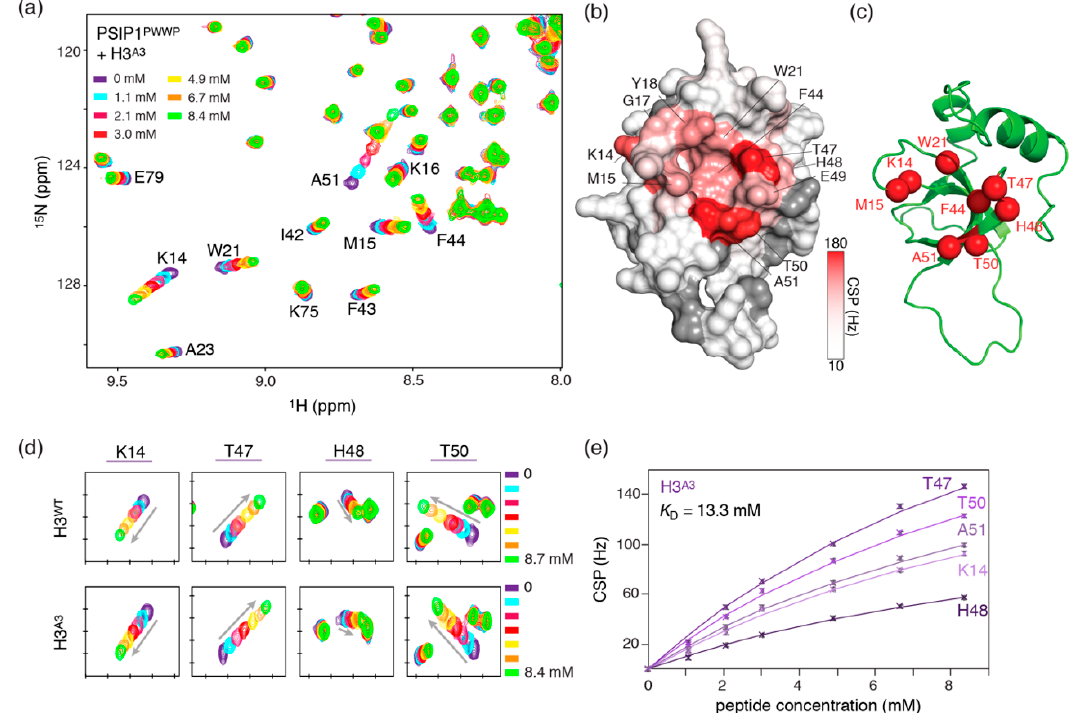
Figure 2. Removal of positive charges in the H3 tail peptide modestly increases PSIP1 PWWP binding. ( a ) Zoom on overlaid 15 N-HSQC spectra of PSIP1 PWWP with increasing amounts of H3 A3 added, showing clear and specific chemical shift perturbations (CSPs). Color coding indicated. ( b ) Surface plot of PSIP1 PWWP with color coding of CSPs (observed at 8.4 mM peptide added), showing largest CSPs in and around the aromatic cage. ( c ) Location of residues used for reporting on aromatic cage binding. ( d ) Zoom on the observed CSPs for aromatic cage reporter residues in both H3 WT and H3 A3 titrations, showing highly similar peak trajectories indicating a similar binding mode. Tic marks are placed each 0.1 / 0.5 ppm in the 1 H / 15 N dimension. ( e ) NMR-derived binding curves with best fits (solid lines) for selected residues together with best-fit value for the K D using a 1:1 binding model global fit of all residues with significant CSP. The plotted binding curves were derived from the CSPs in the 1 H dimension.